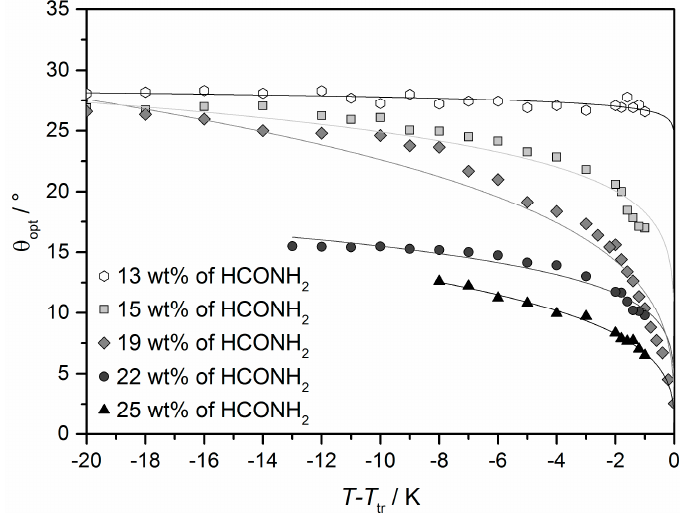
Figure 19. Tilt angle θ opt of the system 4 / formamide measured by rotating a surface stabilized sample between crossed polarizers. The values were plotted relative to the temperature T tr of the phase transition from the high temperature phase to the lyotropic SmC* phase. (Reprinted by permission from John Wiley and Sons: [45].)